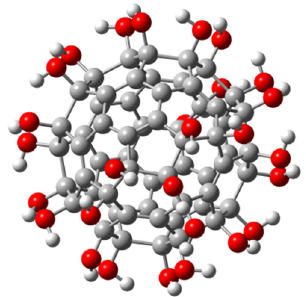
Figure 16. Structure diagram of fullerenol. Oxygen, carbon, and hydrogen atoms are marked in red, gray, and white, respectively.